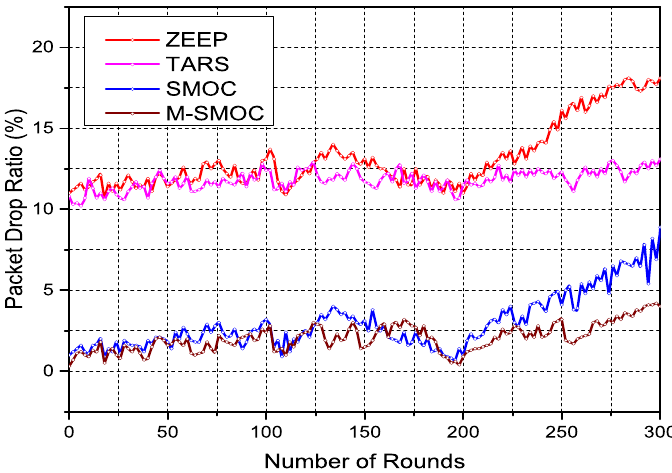
Figure 10. Performance comparison of the packet drop